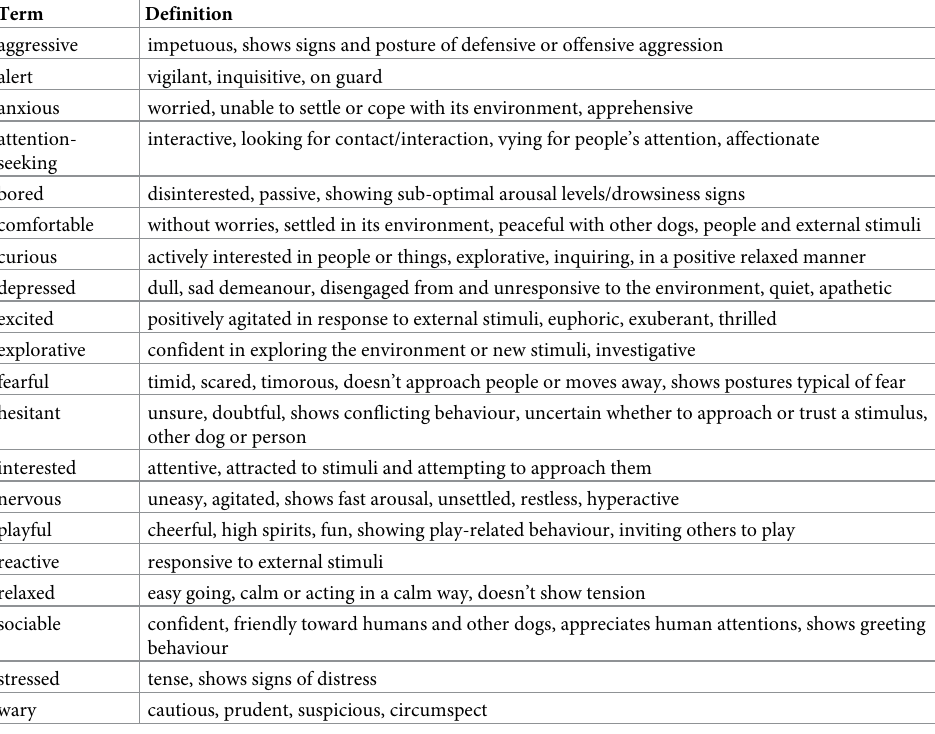
Table 4. Final list of terms and their